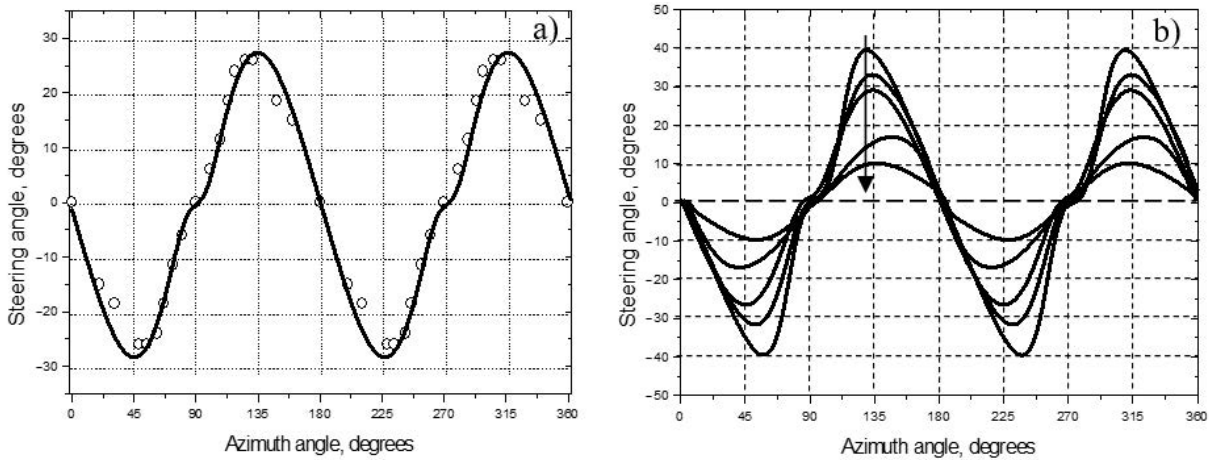
Figure 13. Beam steering effect for a 0 modes in CFRP (( f · D ) = 175): ( a ) calculated in-plane beam steering anisotropy (solid line) and ψ ( α ) derived from WIM measurements (circles); ( b ) dispersion of beam steering: the values of ( f · D ) parameter for the curves in the direction of arrow are: 5, 100, 175, 500, and